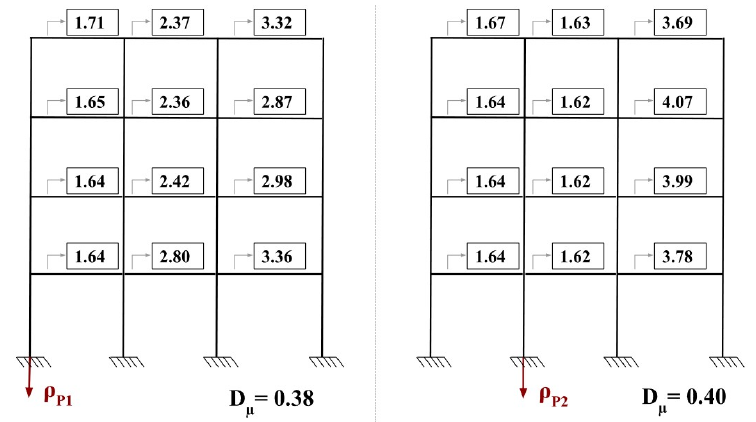
for the internal ( 𝛽𝛽 𝑀𝑀𝑀𝑀